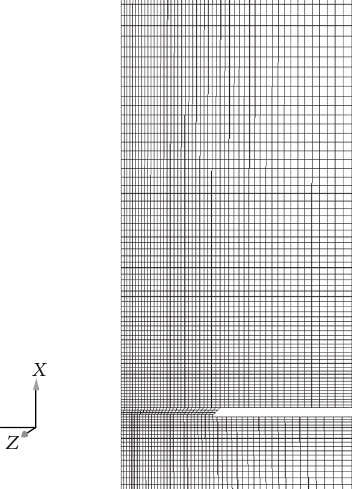
Figure 62: Zoom of the meshing near the